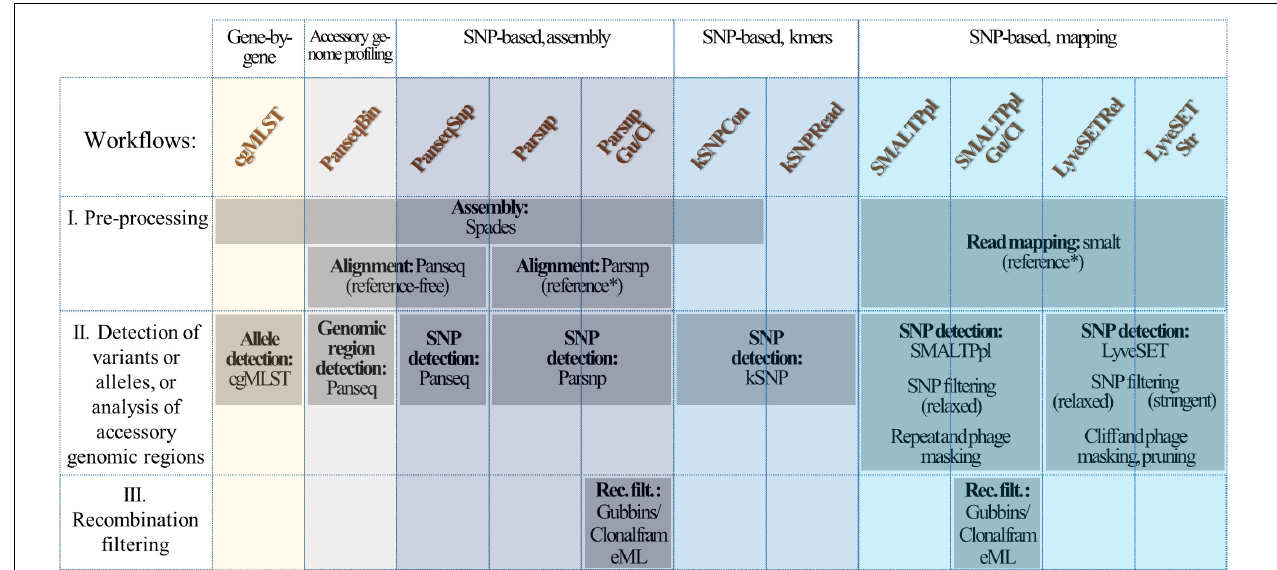
FIGURE 1 | Subtyping workflows. Current study included the following subtyping workflows: a gene-by-gene workflow (cgMLST), a workflow based on accessory genome profiling (PanseqBin), assembly based workflows that used respectively Parsnp and Panseq for alignment of de novo assembled genomes and detection of polymorphisms (Parsnp and PanseqSNP), k-mer-based workflows using kSNP for SNP detection and either assembled contigs (kSNPCon) or reads (kSNPRead) as input, and mapping-based approaches, using either a combination of common tools for read mapping and SNP detection (SMALTPpl) or a high-quality SNP detection pipeline (LyveSETStr and LyveSETRel). PanseqBin, the approach based on accessory genome profiling, measures the differences between isolates based on presence or absence of accessory genomic regions. The two LyveSET-based workflows used different settings, namely in LyveSETStr, a relatively strict set of SNP filtering parameters is applied and in LyveSETRel, a relaxed SNP filtering is performed. Parsnp and SMALTPpl were also tested in combination with either ClonalframeML or Gubbins for filtering of recombinant regions (ParsnpCl/Gu and SMALTPplCl/Gu). Besides LyveSET and Panseq, all workflows have been previously used for subtyping of N. meningitidis (see Materials and Methods), in case of Parsnp and SMALTPpl in combination with either ClonalframeML or Gubbins. Panseq was included to represent an alternative assembly based approach and to evaluate accessory genome profiling for subtyping of N. meningitidis . It was used for characterization of other bacterial organisms marked by higher recombination or genomic rearrangement rates (Stewart et al., 2014; You et al., 2014; Delannoy et al., 2016; Kang et al., 2017). LyveSET was added to the comparison to represent a pipeline with extensive SNP filtering, which also includes the possibility for SNP pruning. ∗ The reference-based pipelines were applied with a high-quality PacBio assembly of one of the